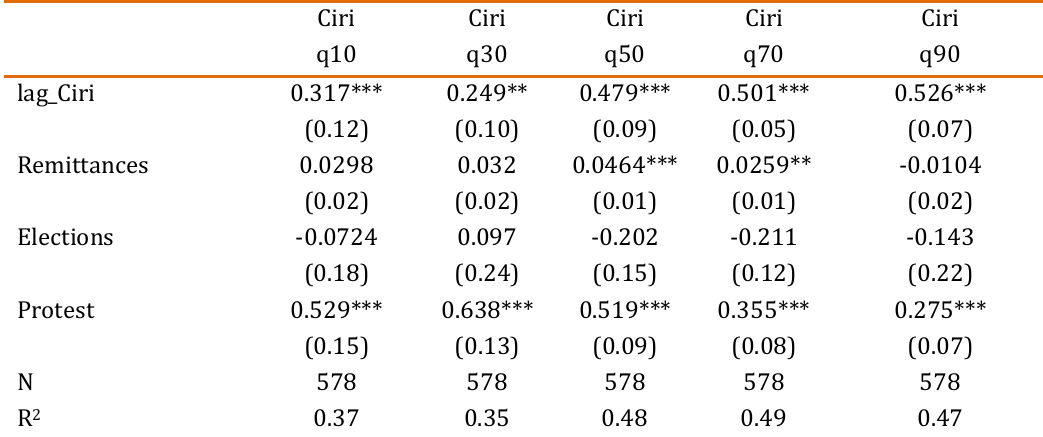
Table 02. Repression changes are calculated on a scale of most extreme (8) to absent (0). A full table with all the results is available from the authors upon request. Table 04. Effect of remittances on violations of rights to physical integrity (1981 – 2014), quantile